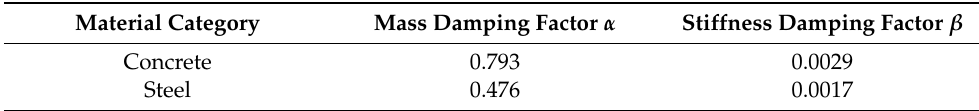
Table 2. Rayleigh damping coefficient of composite beams.